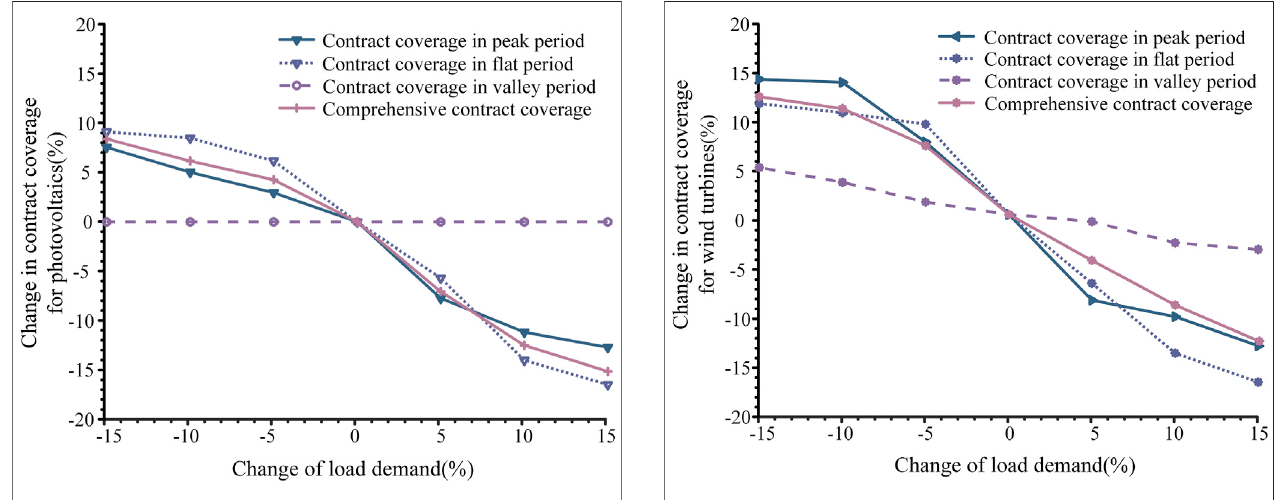
FIGURE 8 | Changes in CCR for photovoltaics under different system load levels.